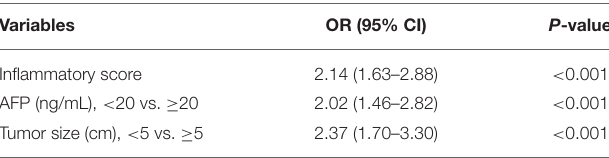
Frontiers in Surgery |